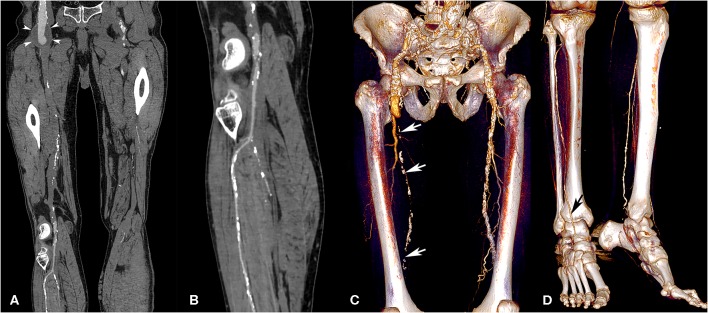
Lower extremity CT angiography obtained with the AA technique in a 75-year-old man with a history of bilateral chronic limb ischemia who had increasing pain on exertion for about a week. Curvilinear reconstructions of the right iliofemoral arterial axis (A) and anterior tibial artery (B) show optimal image quality despite the presence of an aneurysm of the abdominal aorta and right external iliac artery (arrowheads). Volume rendering reconstructions show a long-segment occlusion of the right superficial femoral artery (white arrows, C), yet an optimally enhanced anterior tibial artery (D, black arrow). Attenuation measurements were as follows: aortic level, 235 HU; iliac level, 222 HU (right) and 231 HU (left); femoral level, 188 HU (right), and 233 HU (left); tibial level 235 HU (right), and 218 HU (left); pedal level, 168 HU (right), and 130 (left). HU, Hounsfield units.